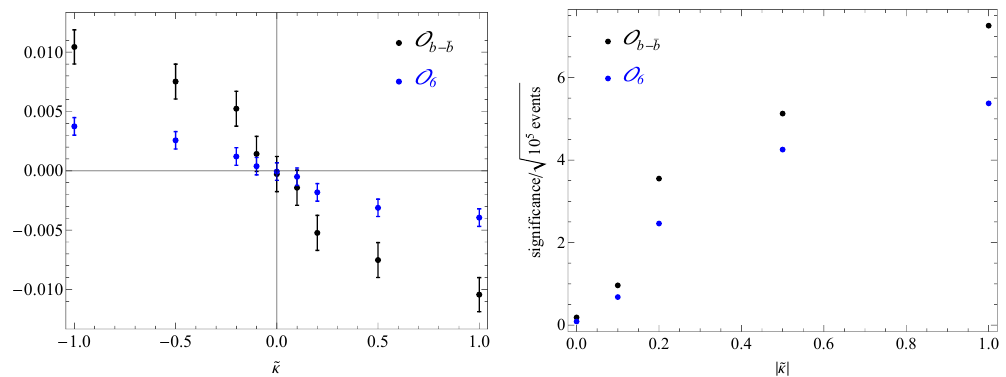
Figure 6 . Left: O 6 (3.8) and O as functions of ~ (cid:20) with (cid:20) = 1 and 10 5 events per ~ (cid:20) at 27 TeV. b (cid:0) (cid:22) b Right: comparison of the signi(cid:12)cances of the same quantities. Compared to O the presented O 6 b (cid:0) (cid:22) b is slightly less signi(cid:12)cant, however the di(cid:14)culties with reconstructing the b -jet charges are